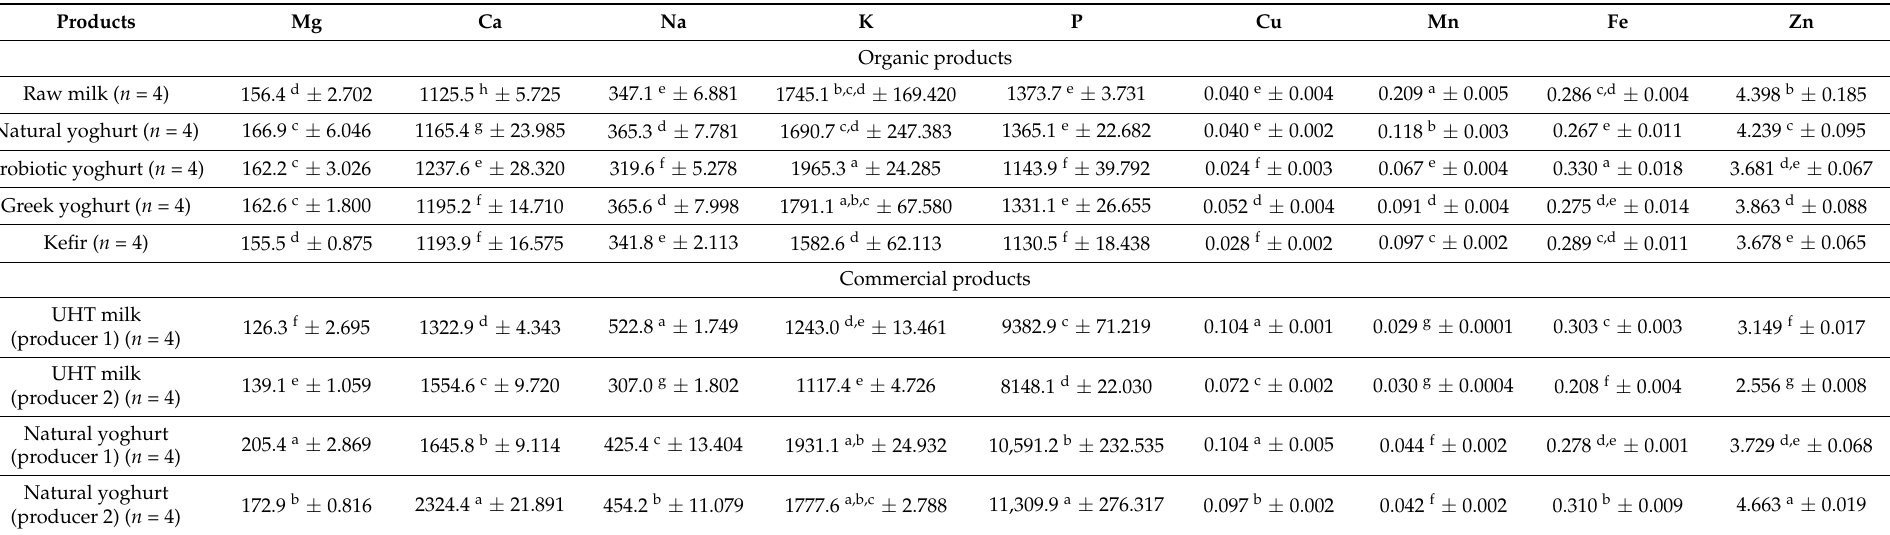
Table 3. Minerals content in goat’s milk and fermented goat’s milk drinks ( µ g/g) (Mean ±